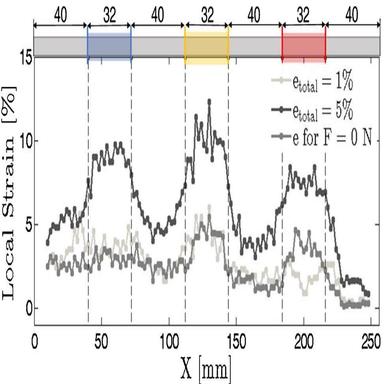
Local strain profile of FGM using uniaxial tensile testing.